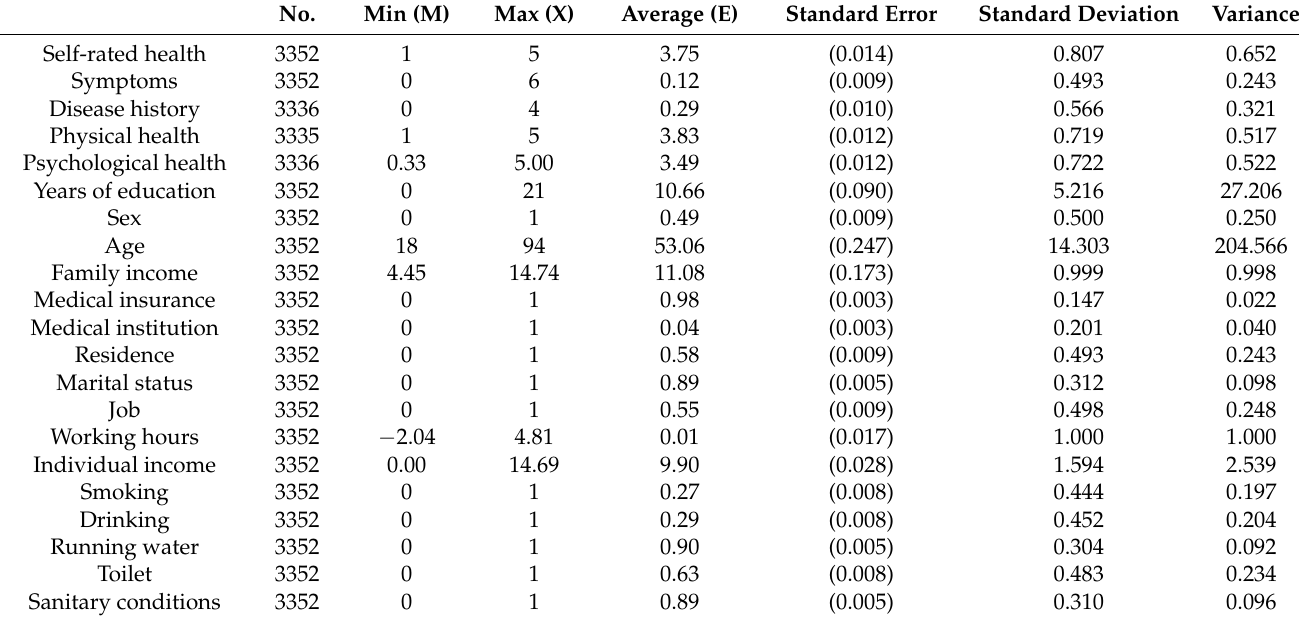
Table 1. Summary statistics of the